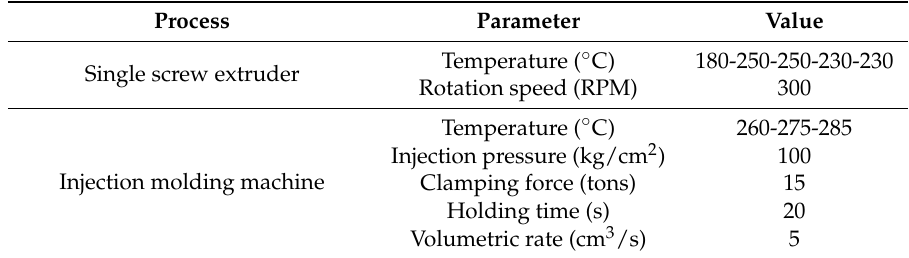
Table 2. Process parameters for a single screw extruder and injection molding machine for specimen preparation.